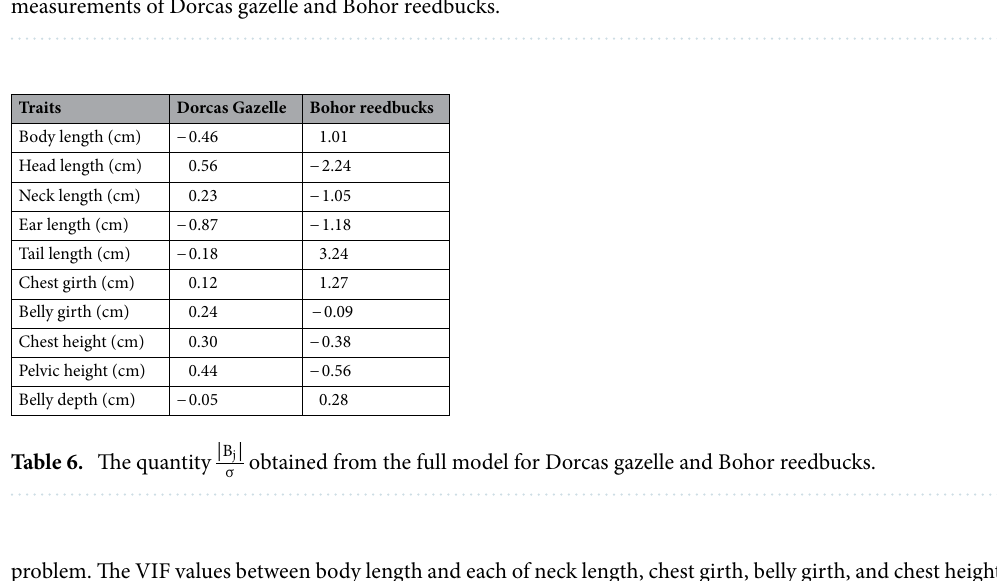
Table 6. The quantity